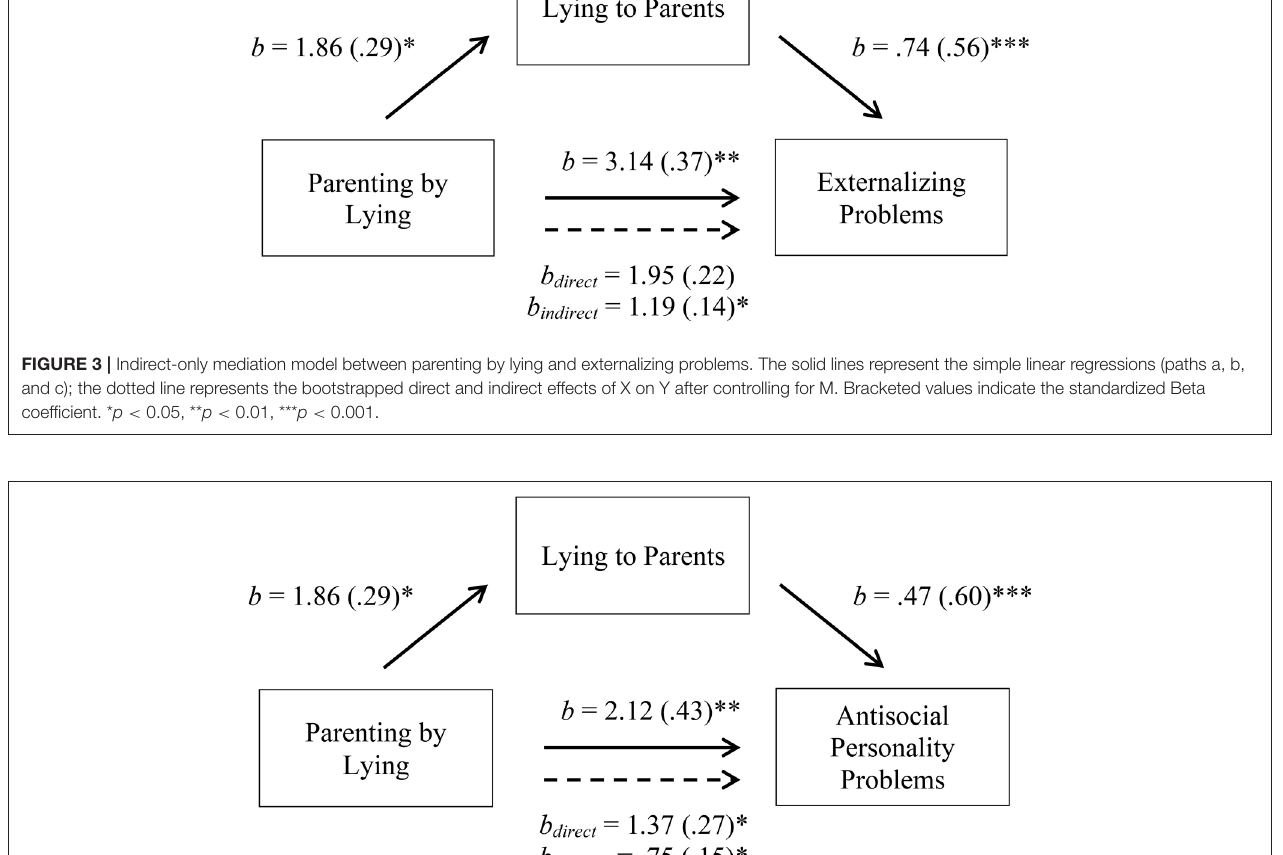
Frontiers in Psychology |